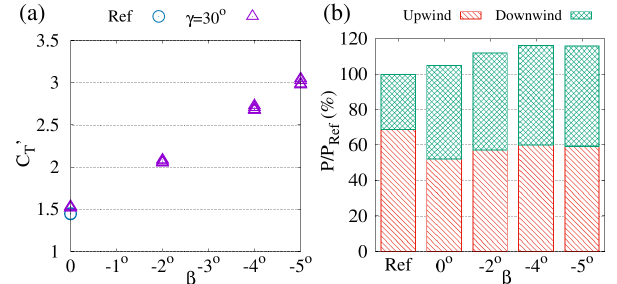
Figure 9. Effect of the yaw angle γ on (a) the local thrust coeffi- cients C (cid:48) of upwind-row turbines when they are operated at β = 0 ◦ of T T or at β = − 5 ◦ and (b) power gains for selected values of rotor- collective blade-pitch angle β